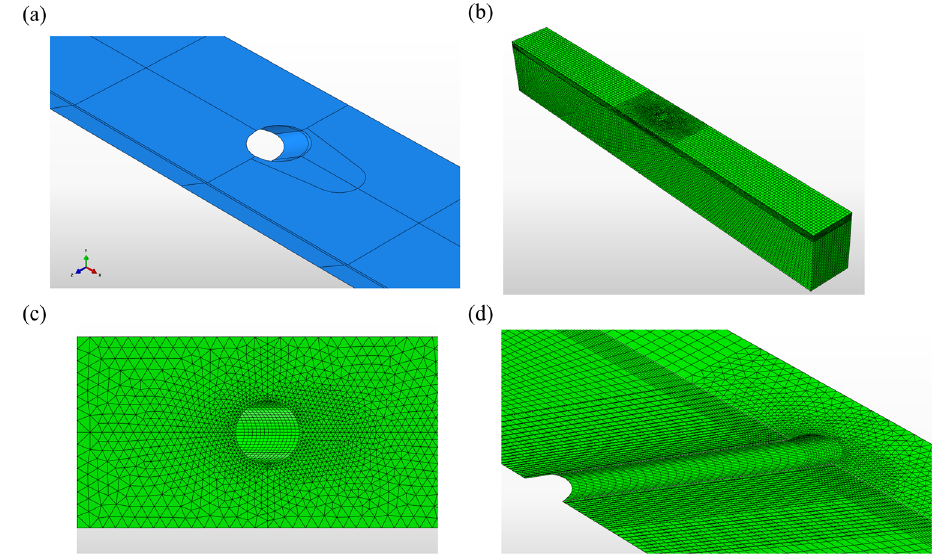
Figure 2. Outlined photograph for ( a ) dividing the solid model into infiltration and non-infiltration zones and meshing ( b ) whole solid domain, ( c ) solid domain in xz plane, and ( d ) half the solid domain.